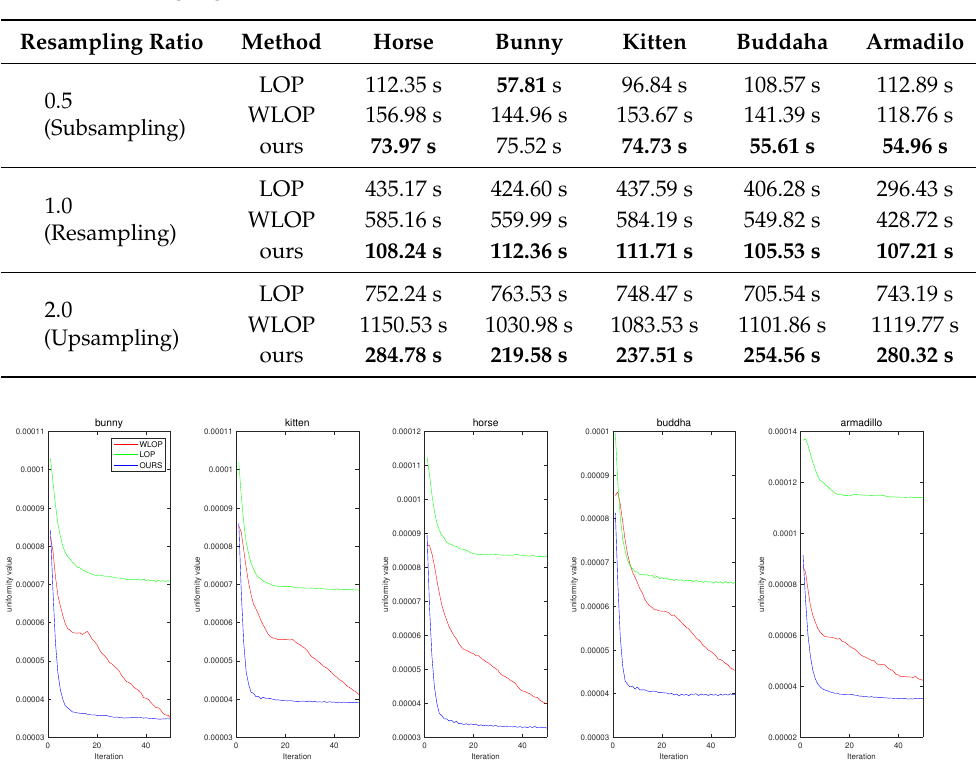
Table 1. Running times of different algorithms for various input data and resampling ratios. The best results are highlighted in bold.